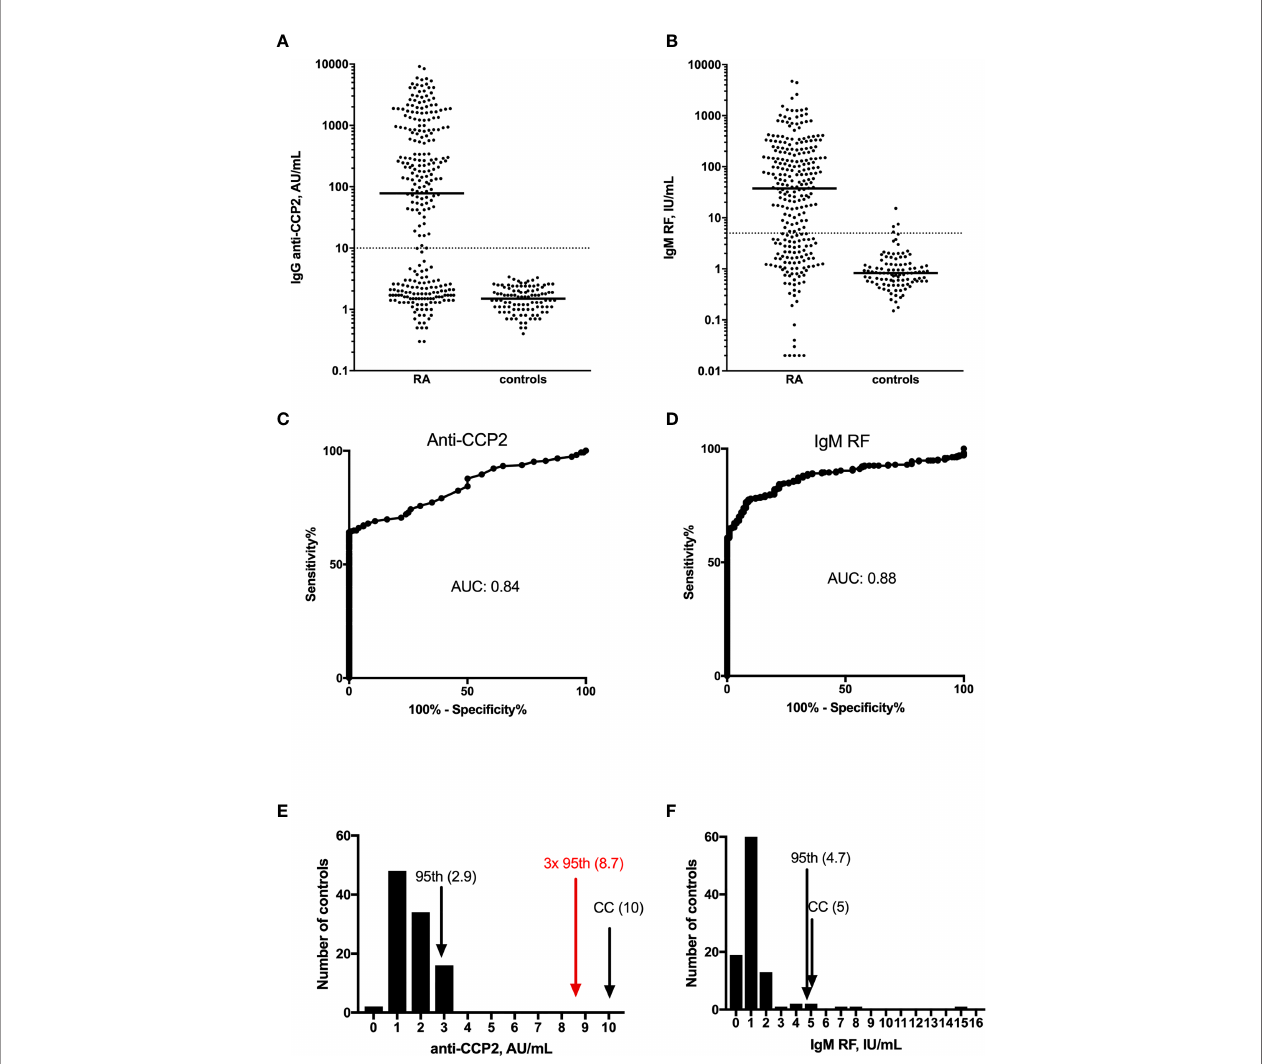
FIGURE 2 | Distribution of (A, C, E) anti-CCP2 and (B, D, F) IgM RF among 268 RA patients and 100 healthy blood donors from Sweden. In (A, C) . dot blots are shown with the medians depicted as horizontal solid lines. The dotted horizontal lines depict the cut-off points for clearly positive responses, as suggested by the manufacturer. In (B, D) , the corresponding Receiver Operator Characteristics (ROC) curves are shown; including information about Area Under the Curve (AUC). In (E, F) the distribution of the 100 controls is depicted for anti-CCP2 and IgM RF, with vertical arrows depicting the 95th percentile among the 100 controls (95th), the company-suggested cutoffs (CC), and in (E) the value three times higher than the 95th percentile (3x 95th, in red). Figures within parentheses show the corresponding measurement